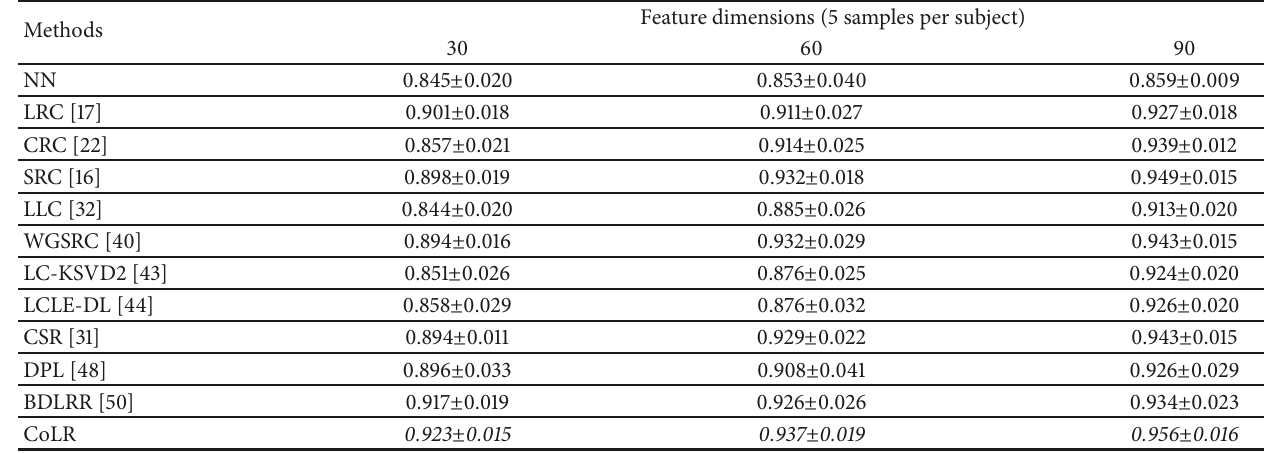
Table 4: Recognition rates on the ORL dataset under different feature